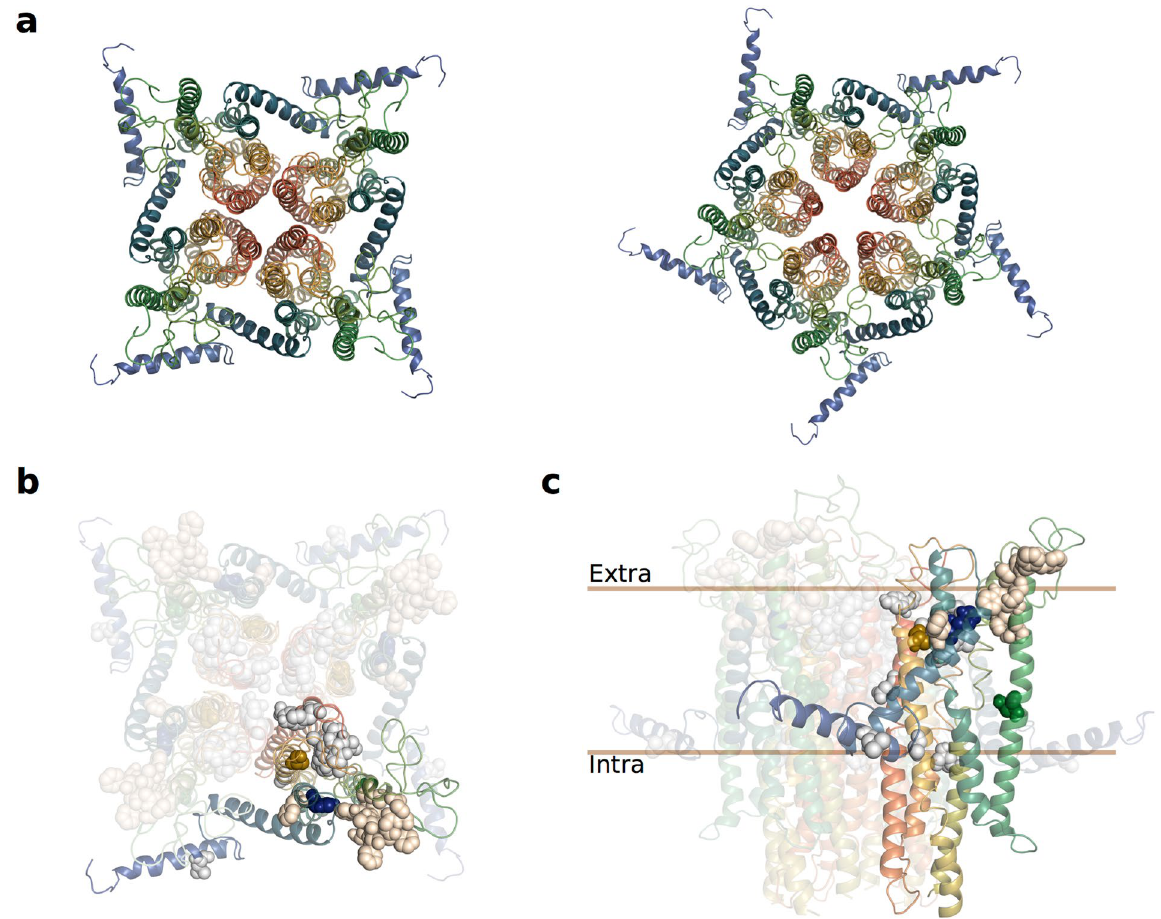
Figure 6. ( a ) 3D models of putative Mayetiola destructor (Mdes) Orco tetra- and pentamers, viewed from the extracellular surface. ( b ) Putative tetramer model of MdesOrco multimer, viewed from extracellular surface, with selected residues shown in sphere representation. Blue (H81F), green (N133L) and gold (S350A) spheres represent MdesOrco residues mutated in this study. Grey spheres represent corresponding residues associated with cation selectivity or ion channel function; tan spheres represent residues associated with ligand binding 34 . ( c ) Side view of MdesOrco tetramer with selected residues shown in sphere representation as described in ( b ). Note: protein models are coloured from blue (N-termini) to red